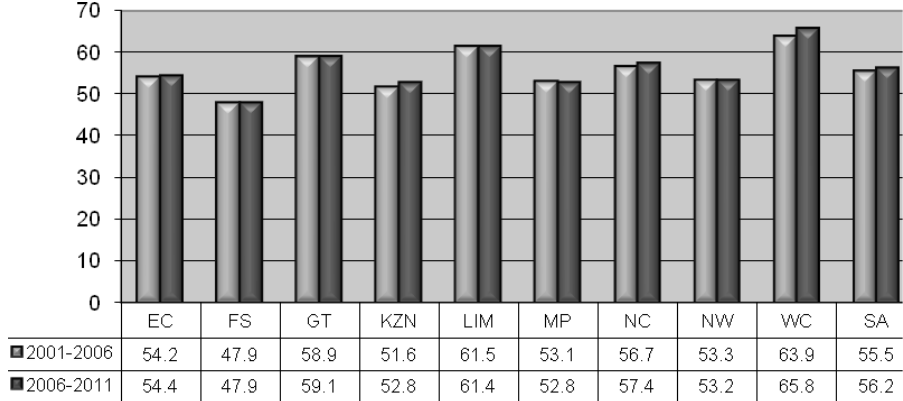
FIGURE 3: Life expectancy per province (female) Source: Statistics South Africa